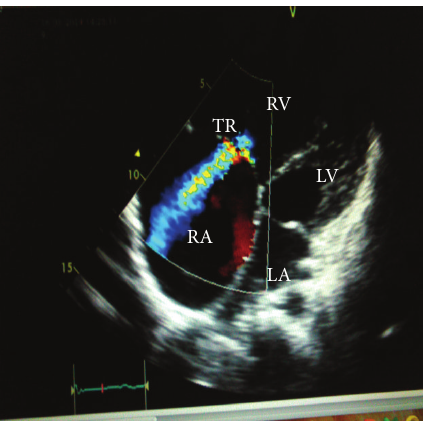
Figure 1: A 4-chamber view with color Doppler showing the tricuspid regurgitation (TR), enlarged right atrium (RA), enlarged right ventricle (RV), compressed left atrium (LA), and compressed left ventricle (LV) before adenotonsillectomy.